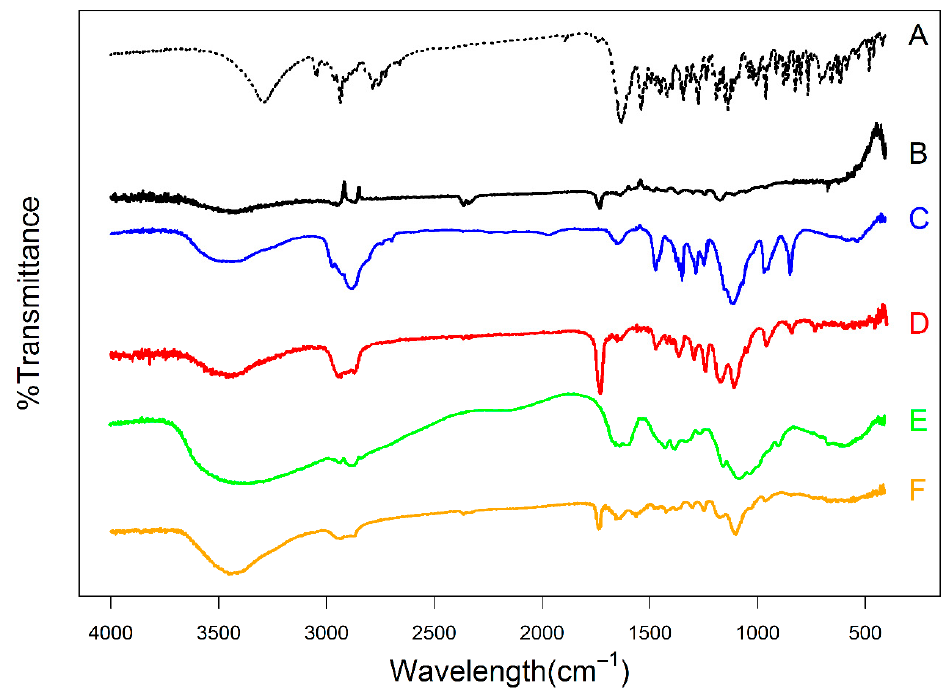
Figure 4. FT-IR spectra of ( A ); PP, ( B ); PCL, ( C ); Pluronic F127, ( D ); F3, ( E ); chitosan, and ( F ); F4.